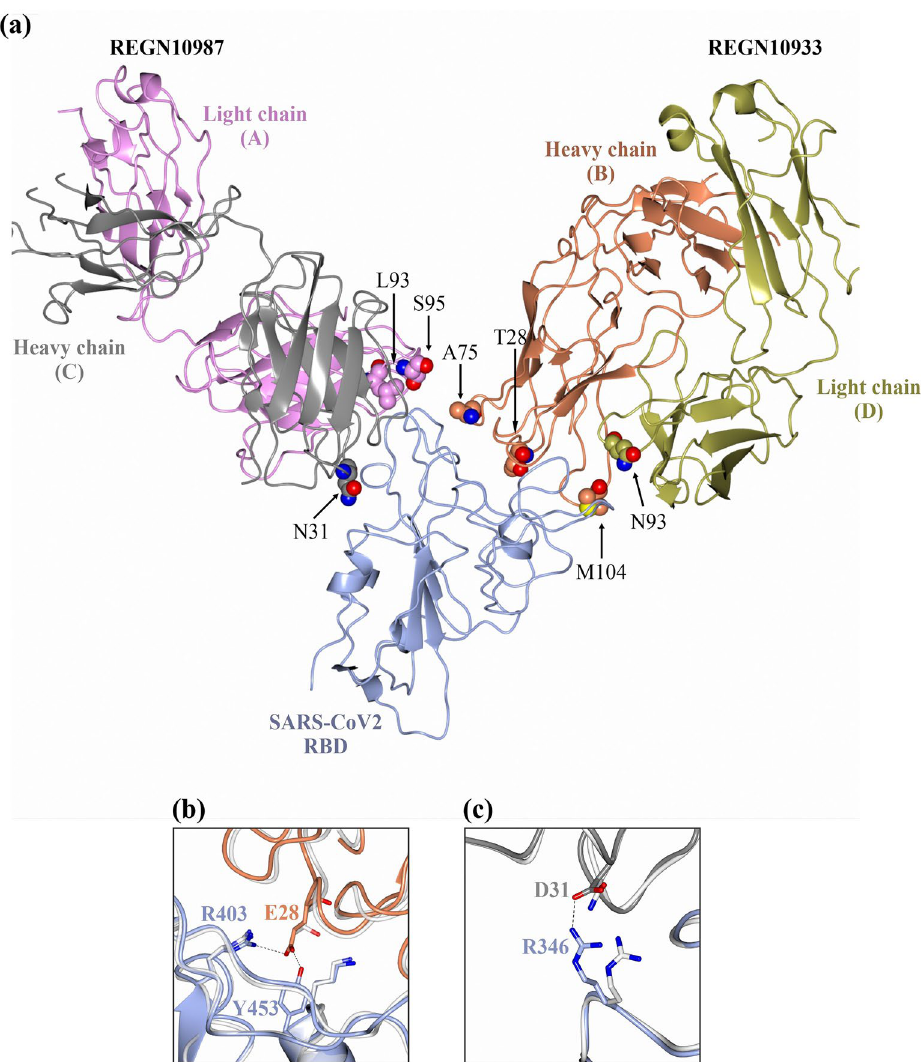
Figure 4. ( a ) Graphical illustration of the REGN10987 and REGN10933 Fabs bound to the SARS-CoV-2 receptor binding domain (RBD). The interface residues selected for mutation by in silico analysis have been highlighted. ( b ) Schematic representation of Thr28 of the heavy chain B (brown) mutated to Glu (E) which allows salt bridge and H-bond formation with Arg (R403) and Tyr (Y453) respectively on the SARS-CoV-2 RBD surface (blue). ( c ) Schematic representation of Asn31 of the heavy chain C (grey) mutated to Asp (D) which allows salt bridge formation with Arg (R346) on the SARS-CoV-2 RBD surface (blue). The mutations performed in silico have been overlayed against the original interactions (white backbone) and the predicted interface post energy minimization is shown. All graphical illustrations have been generated using the CCP4 Molecular Graphics program version 2.10.11 (https:// www. ccp4. ac. uk/ MG/) 46